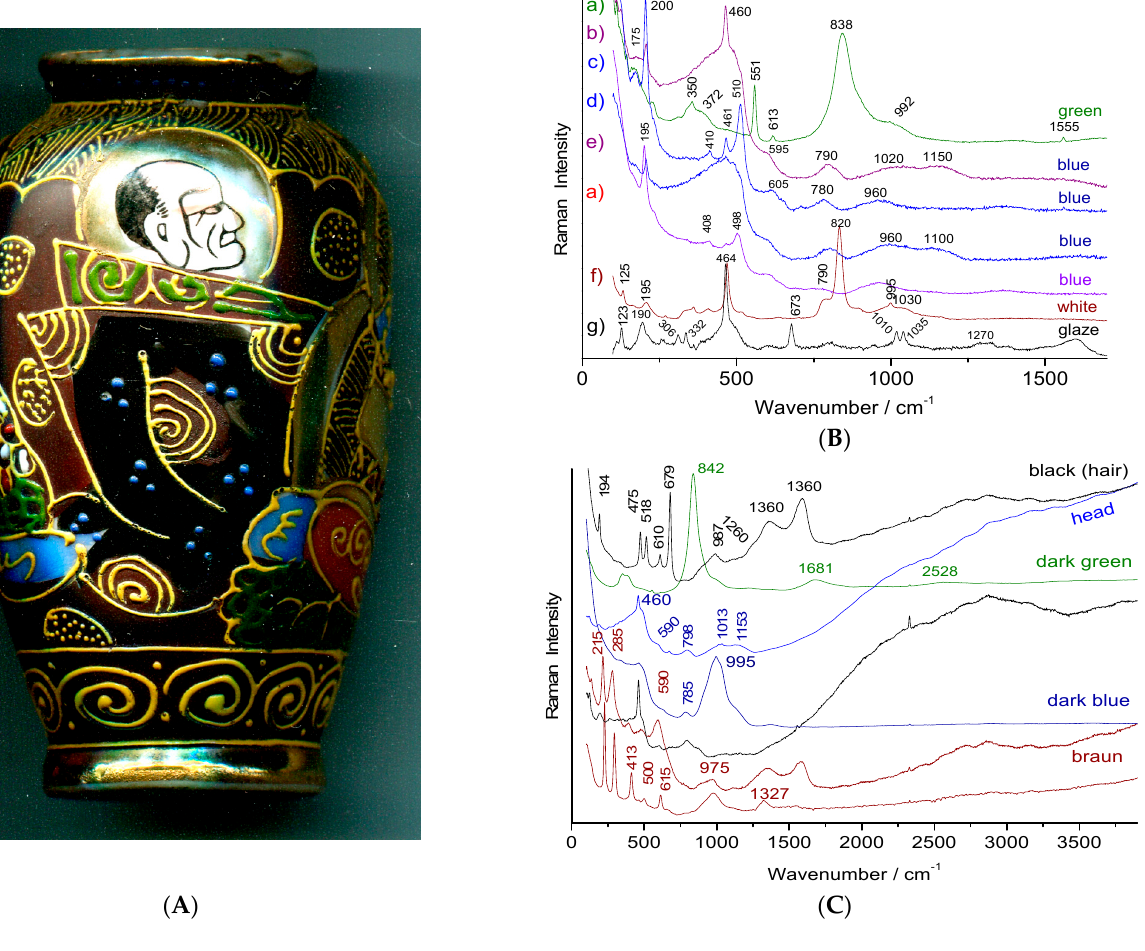
Figure 10. Representative Raman spectra recorded on Satsuma enamel vase from the end of 19th century ( A ) and Figure 2d; ( B ) 514.5 nm laser excitation; ( C ) 457 nm laser excitation; colored areas examined are given.